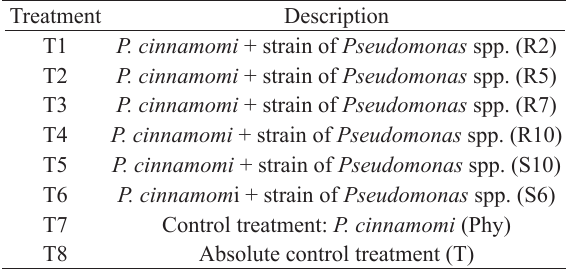
Table 1. Treatments used in the present study. Treatment